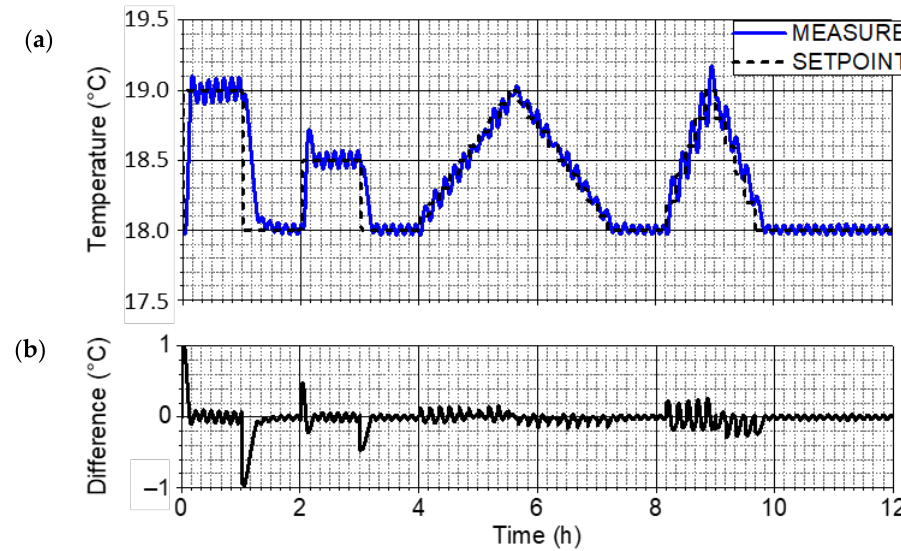
Figure 13. Temperature evolution of a wall for different temperature step changes ( a ) and the error between measure and set point ( b ).